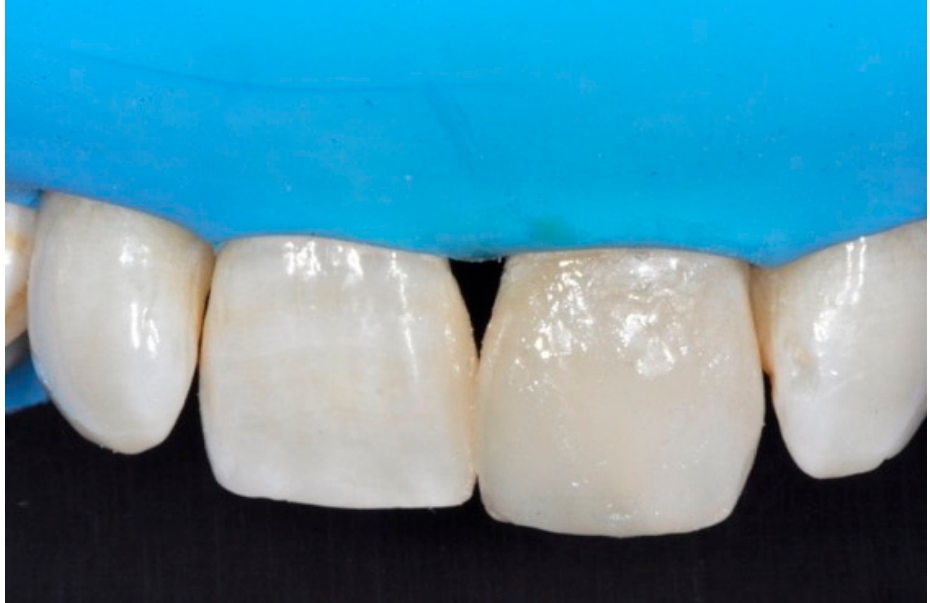
Figure 46. External enamel layer is applied.